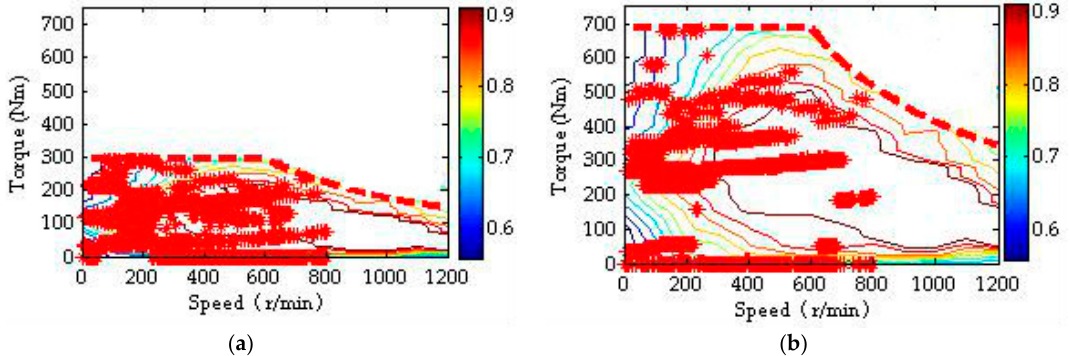
Figure 15. Operating points for ( a ) the front-axle motors and ( b ) the rear-axle motors under the case of OSOC and constructed driving cycle.